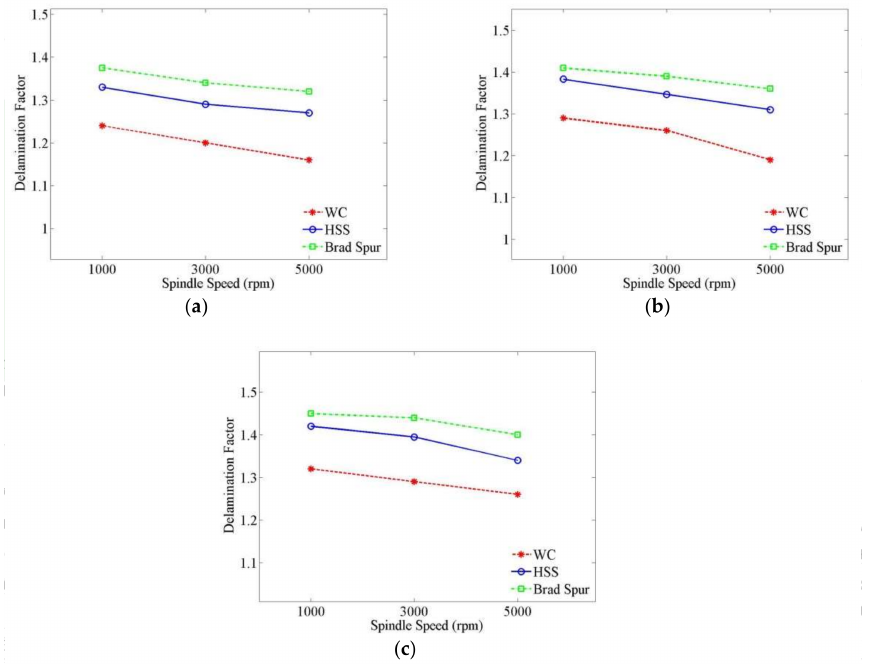
Figure 9. Variation of drilling parameters on delamination: ( a ) 0.05 mm/rev; ( b ) 0.10 mm/rev; ( c ) 0.15 mm/rev.